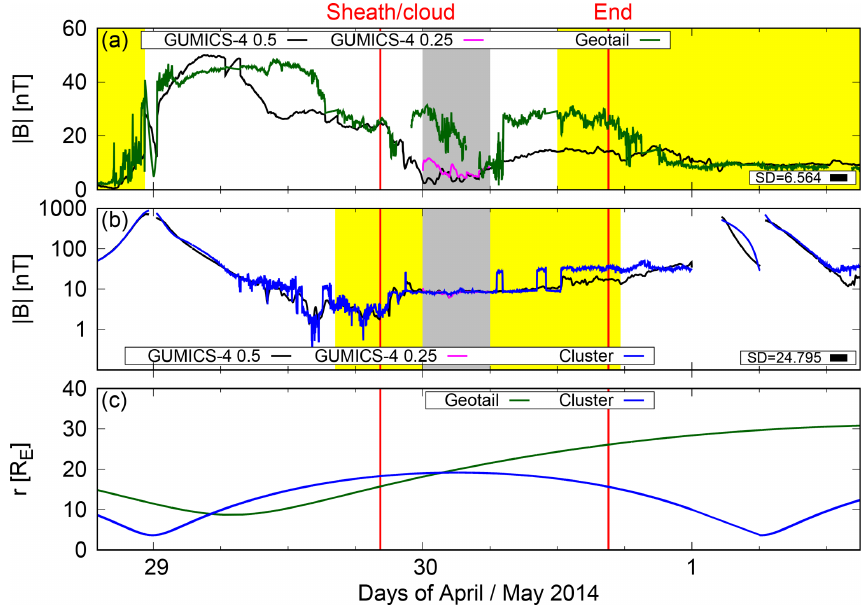
Figure 5. The time series of the magnetic field magnitude | B | along the orbits of Geotail (a) and Cluster 1 (b) during 28 April 19:00UT– 1 May 17:00UT, 2014 as measured by Geotail (green) and Cluster 1 (blue) and predicted by GUMICS-4 (black and magenta). Black and magenta curves in panels (a) – (b) show GUMICS-4 results with maximum spatial resolutions of 0.5 (black) and 0.25 (magenta) R E . (c) Radial distance of both spacecraft from the center of the Earth. Yellow-shaded regions indicate approximate time intervals when a satellite may exit the magnetosphere. Grey-shaded regions show the part of the ICME event simulated also using 0.25 R E maximum spatial resolution. SDs for observation vs. GUMICS-4 (0.5 R E resolution) datasets are given in panels (a) and (b)